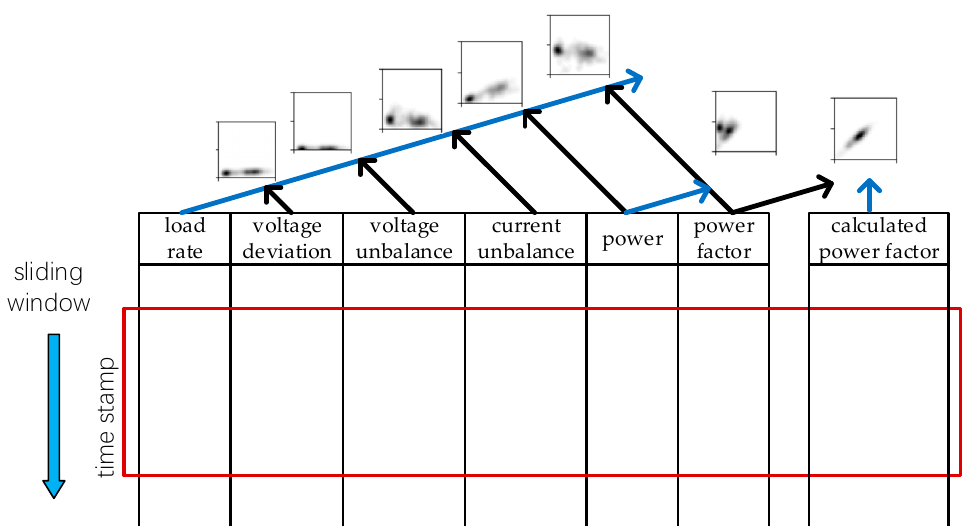
Figure 4. The generation of the seven-channel super image. Each image channel is generated with a combination of the data columns shown in the figure. Blue lines indicate the columns of features used as x-axis data while black lines indicate the column used as y-axis data. The rectangular box in red is the sliding window that covers a certain time range of data. Here we have another feature named calculated power factor. This is the power factor we calculated with the power and load rate values.